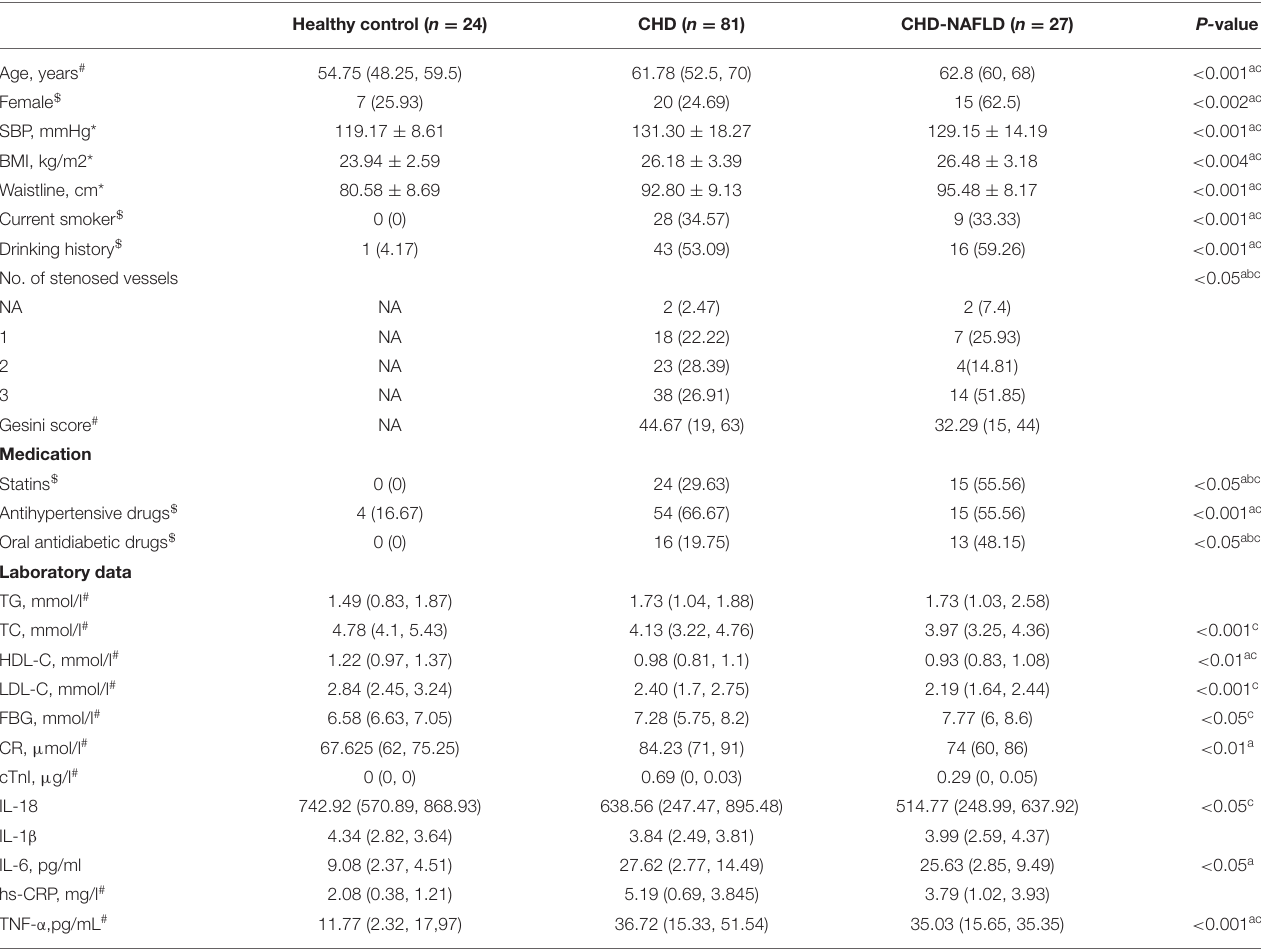
TABLE 1 | Characteristics of the study